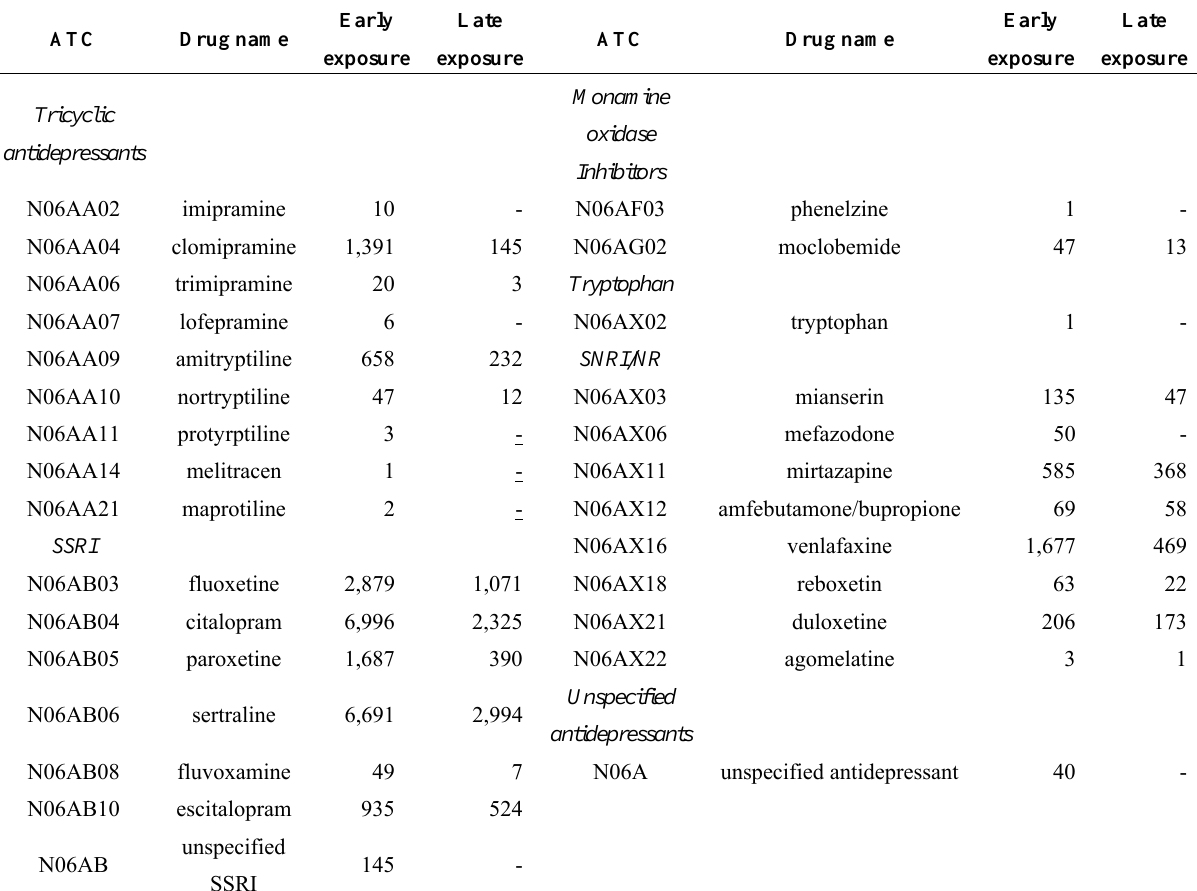
Table 33. Number of infants exposed in early pregnancy for antidepressants or was born of women who filled prescriptions for antidepressants during the 2nd or 3rd